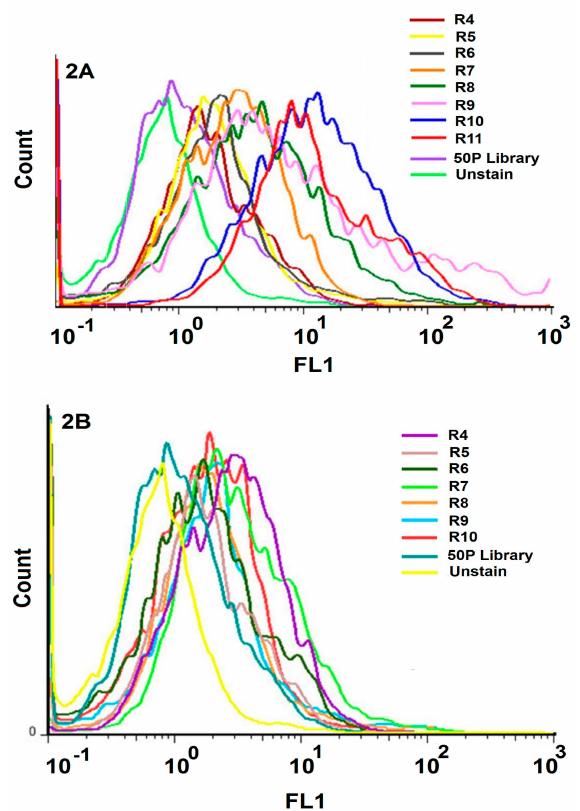
Figure 2. Evaluation of the binding affinity of aptamer pools from each round of Cell-SELEX(R) to the CD20 protein expressed on the surface of HEK293T cells. ( 2A ) the binding affinity of ssDNA after seven rounds of Cell-SELEX (rounds 4 to 10) after 11 rounds of Cell-SELEX on CD20 + HEK293Tcells; ( 2B ) The binding affinity of pools from seven rounds of Cell-SELEX (rounds 4 to 10) after 10 rounds of Cell-SELEX on HEK293T cells. 50 pmol of the library was used as a negative control. Since the 10th round pool was selected as a final product; the 11th round for HEK293T cells was not applicable to show inside the Figure